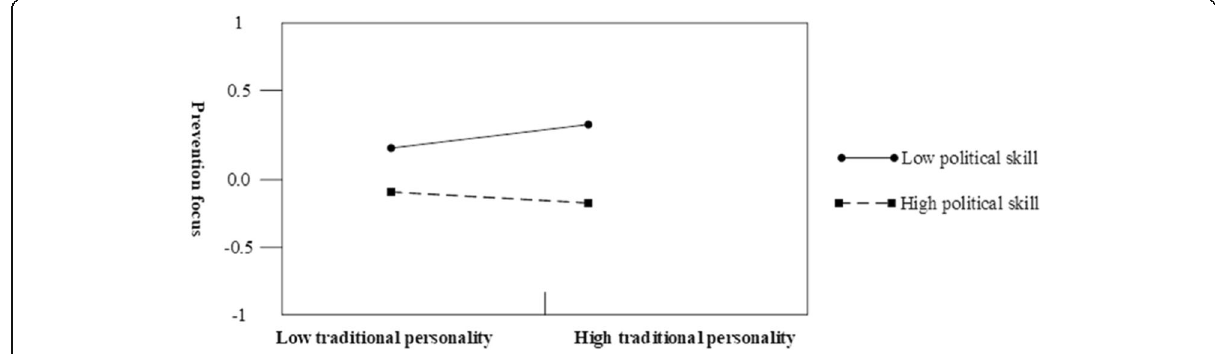
Fig. 4 Moderating effect of political skill